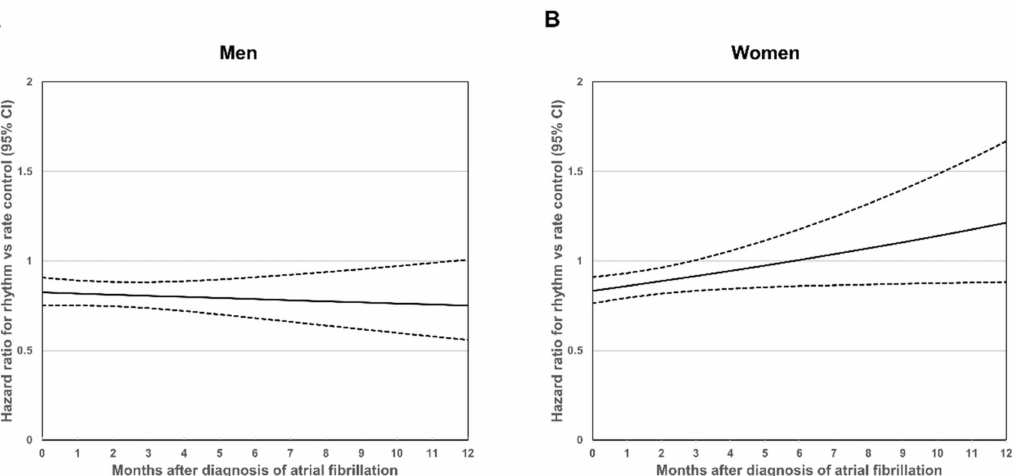
Figure 2. Relationship between treatment timing and primary composite outcome risk. Data shown are within 1 year after the first diagnosis of atrial fibrillation. ( A ) Men. ( B ) Women. Hazard ratio = 1 means an equal risk of outcomes in participants treated with rhythm- and rate-control. Dashed black lines show the 95% confidence